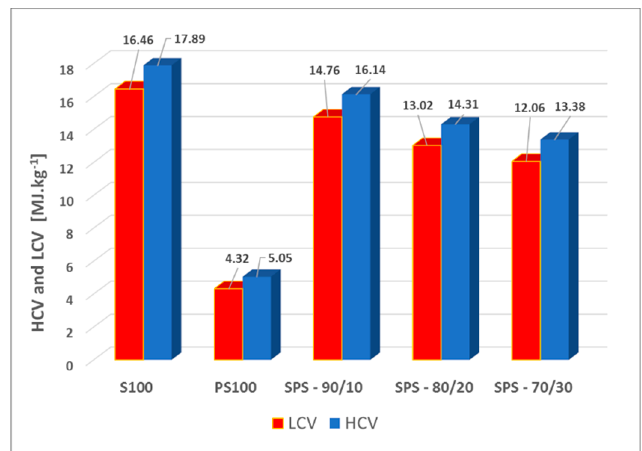
Figure 3. Higher and lower calorific values of produced samples.